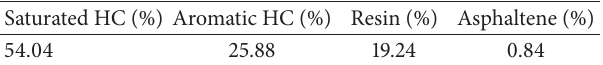
Table 1: The group compositions of the crude oil. Saturated HC (%) Aromatic HC (%) Resin (%) Asphaltene (%) 54.04 25.88 19.24 0.84